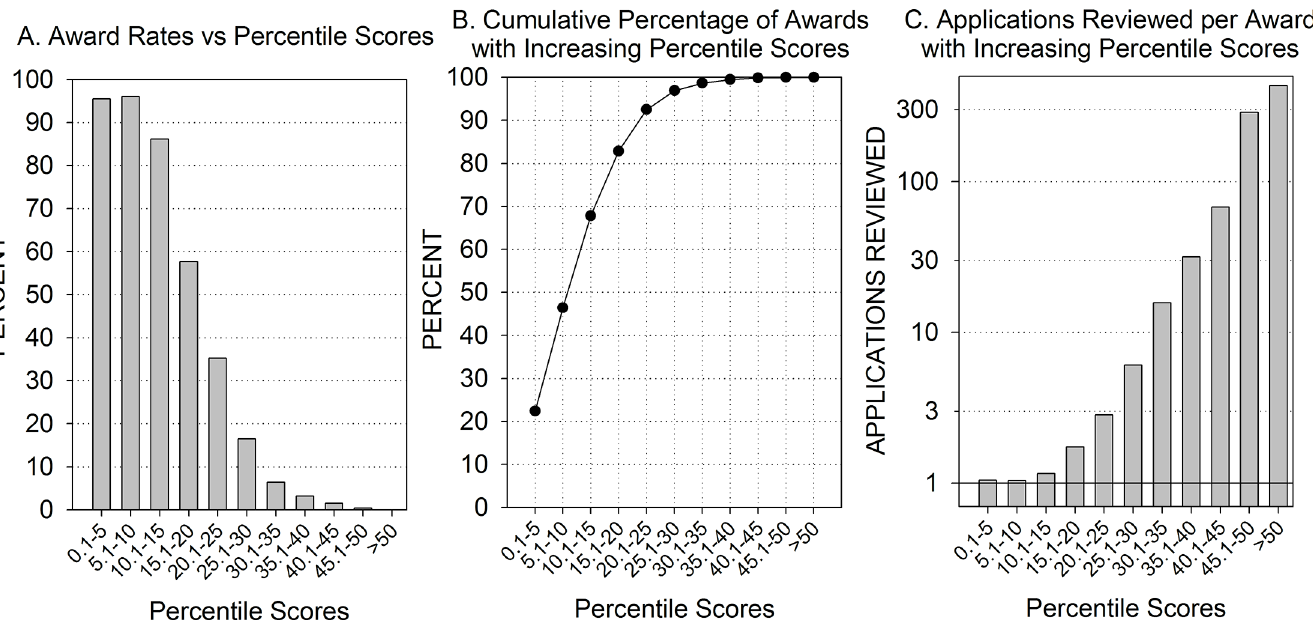
Fig 1. [A] Percent of applications funded decreases as peer review percentile scores increase. Approximately 95% of all applications with peer review percentile scores in the 0.1 – 10.0 range are funded, but only 3.2% of the applications with peer review scores in the 35.1 – 40 percentile range are funded. [B] Cumulative percentage of all funded applications with increasing peer review percentile scores. Almost 50% of all funded applications have peer review percentile scores in the 0.1 – 10 range, and 97% of all funded applications have peer review percentile scores equal to or less than 30. [C] Number